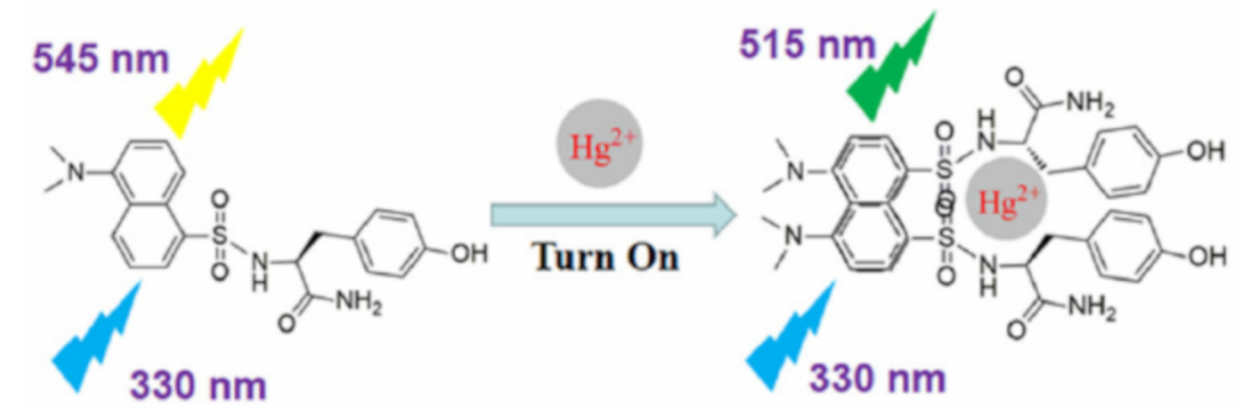
Figure 22. Proposed principle of 62 for detecting Hg 2+ . Reproduced with permission from [90]. Copyright 2020 Elsevier.